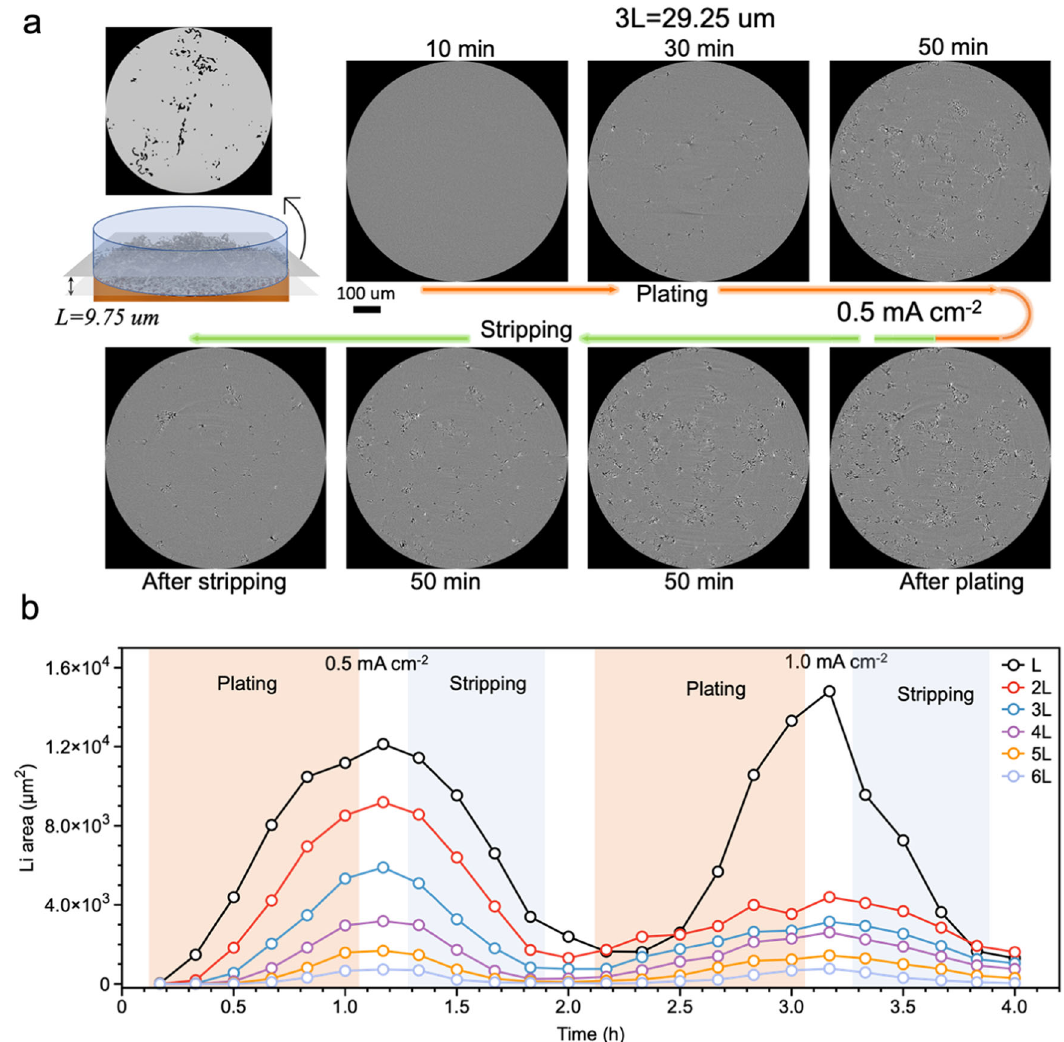
Fig. 6 | Spatial evolution of Li microstructures during plating and stripping cycles. Horizontal slices at fi xed distances, n·L=n·9.75 μ m (L represents the total length of 30 voxels, 9.75 μ m) from the Cu substrate are taken from each 3D tomogram (1 – 10L), same tomogram as those in Supplementary Figs. 3 and 4. a Slicestakenat3L(29.25 μ mfromtheCusubstrate)areshownasanexample.Dark